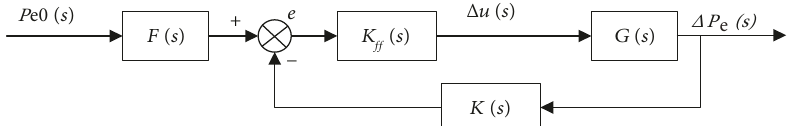
Figure 9: The block diagram of pressure control for the insulation space.